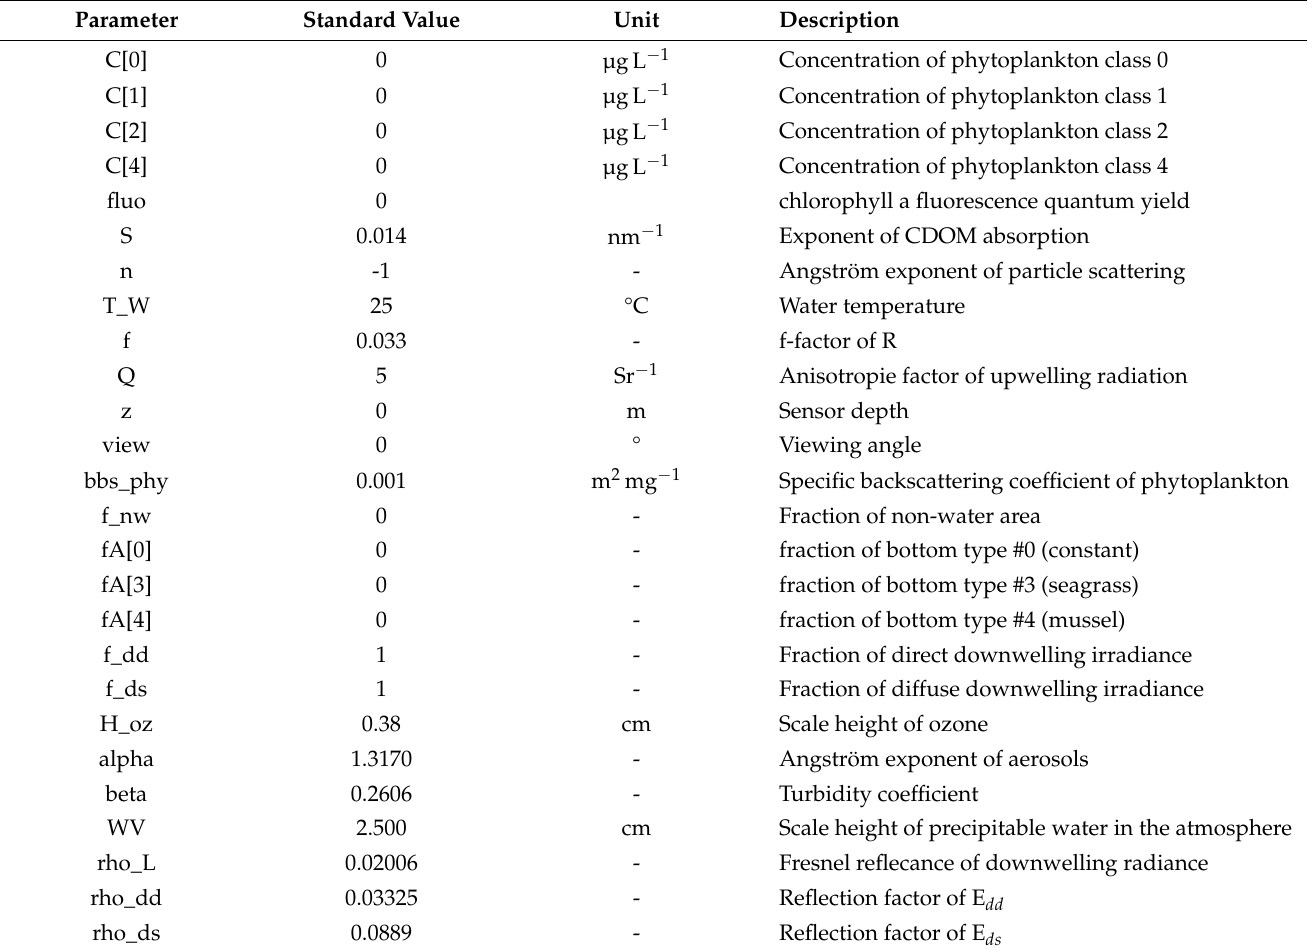
Table A1. Summary of the default WASI simulation parameters (see